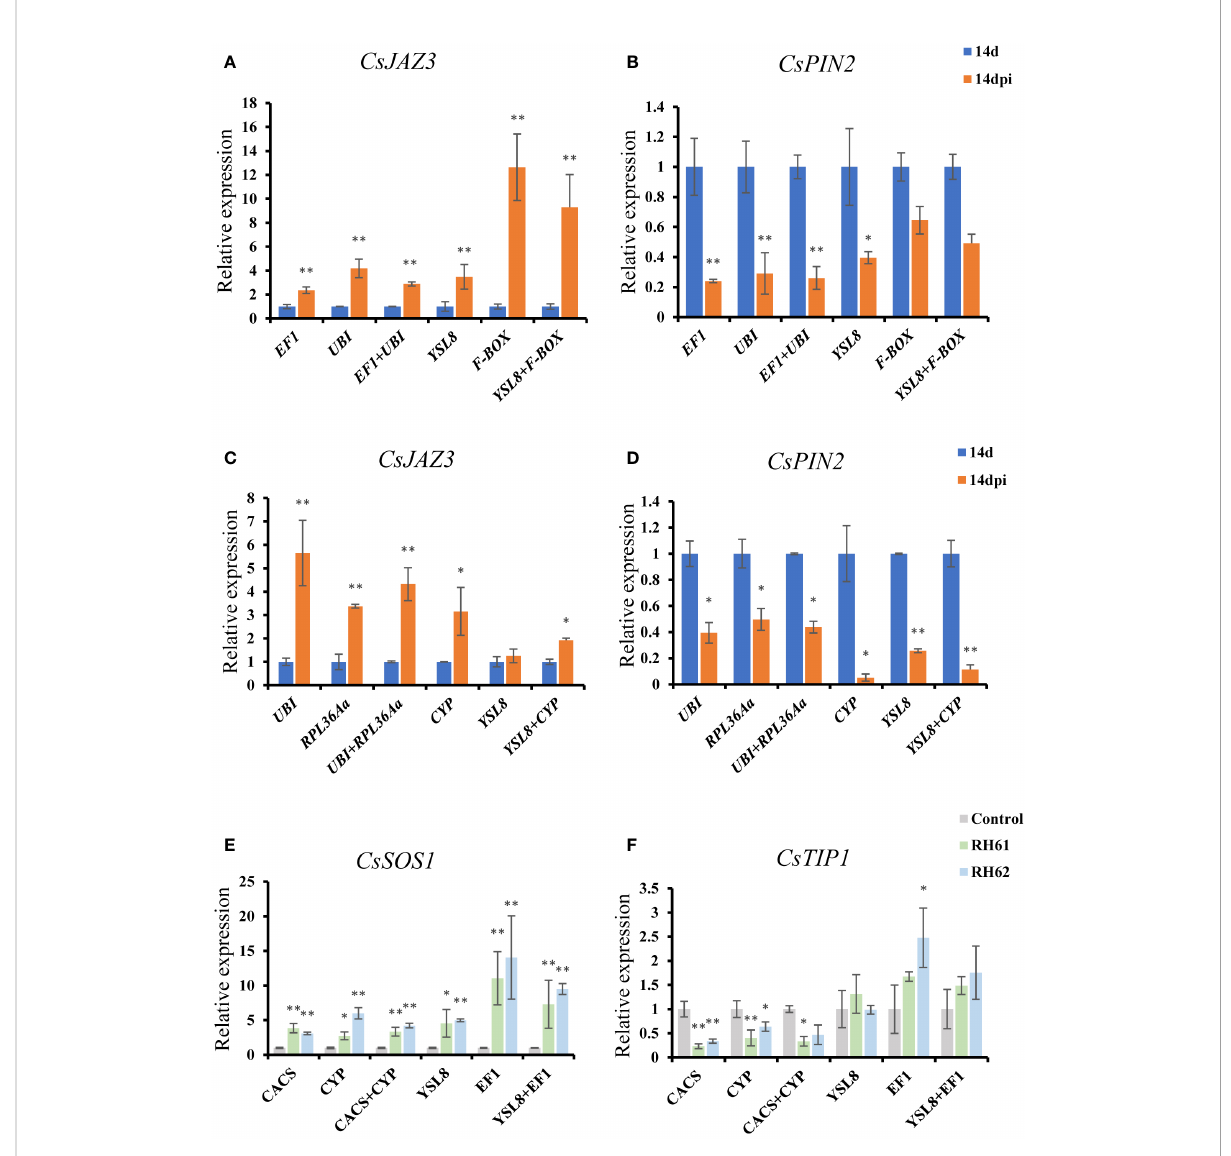
FIGURE 5 Pro fi ling of CsJAZ3 , CsPIN2 , CsTIP1 and CsSOS1 expression in cucumber roots of treatment 1, 2 and 3 using the most suitable and least suitable sets of candidate reference genes. (A, B) , normalized CsJAZ3 and CsPIN2 expression using the most suitable candidate reference genes ( EF1 and UBI ) and the least suitable candidate genes ( YSL8 and F-BOX ) in treatment 1; (C, D) , normalized CsJAZ3 and CsPIN2 expression using the most suitable candidate reference genes ( UBI and RPL36A a ) and the least suitable candidate genes ( YSL8 and CYP ) in treatment 2; (E, F) , normalized CsTIP1 and CsSOS1 expression using the most suitable candidate reference genes ( CACS and CYP ) and the least suitable candidate genes ( YSL8 and EF1 ) in treatment 3. Abbreviation: 14 d, 14 day; 14 dpi, 14 days post infection by M. incognita . RH61 and RH62 are two kinds of Pseudomonas . "*"and"**" indicate a signi fi cant difference from the those based on t-test, with a P-value of 0.05 and 0.01